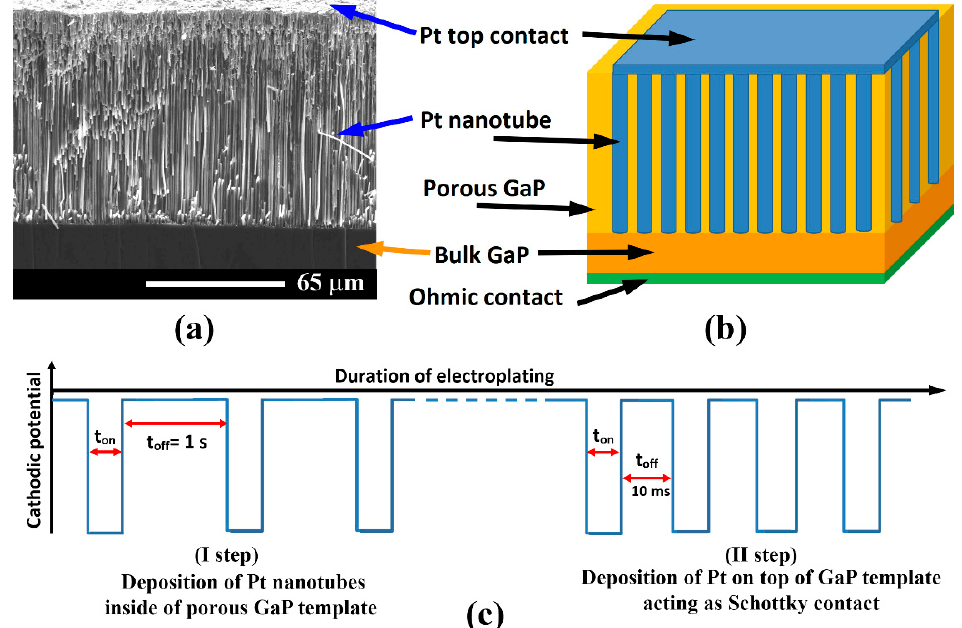
Figure 5. ( a ) SEM image in cross-section, of 100 μ m deep porous GaP/Pt template; ( b ) the sche- matic presentation of the varicap device structure; ( c ) the sequence of pulses and pause between them during Pt electroplating in porous GaP template for Pt nanotubes and top contact deposition in the same technological process.